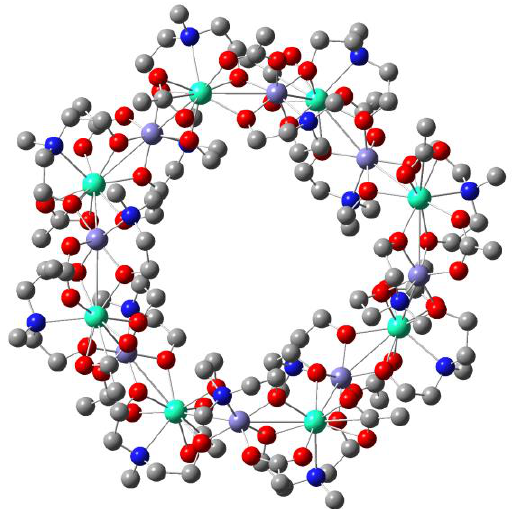
Figure 14. Crystal structures of [Fe 8 Dy 8 (mdea) 16 (CH 3 COO) 16 ] · CH 3 CN · 18H 2 O. Dy, dark cyan; Fe,